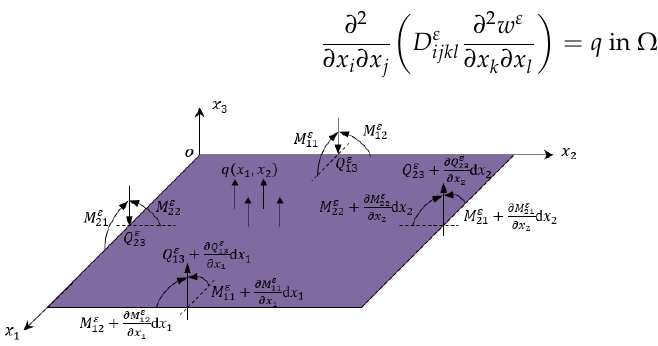
Figure 2. Forces acting on an infinitesimal element of the plate.